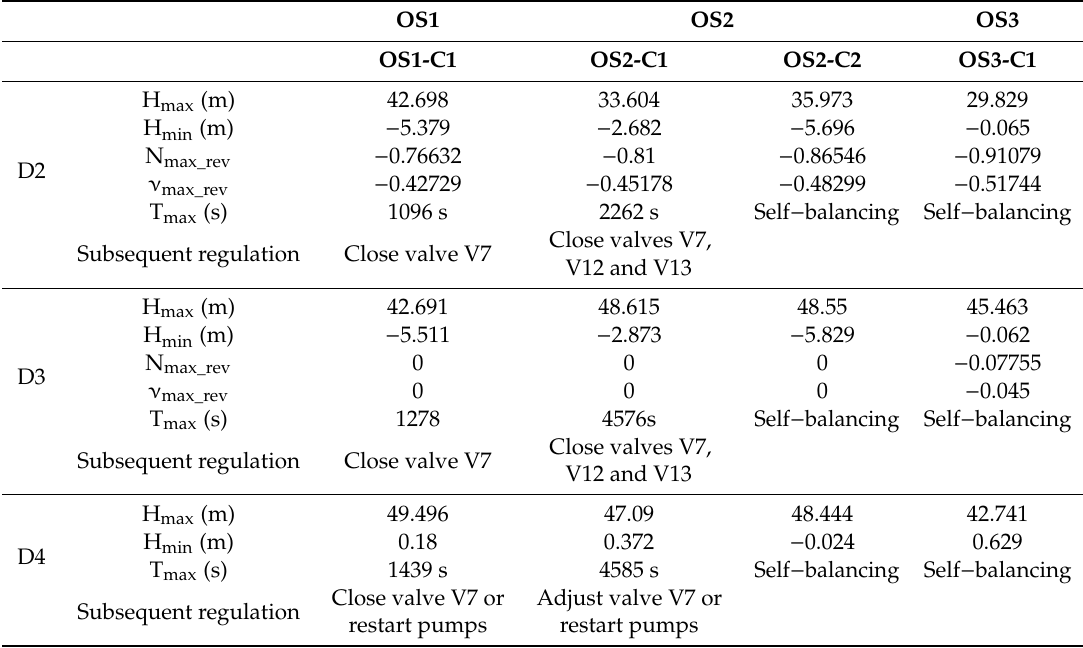
Table 5. The transient processes in three operating scenarios under